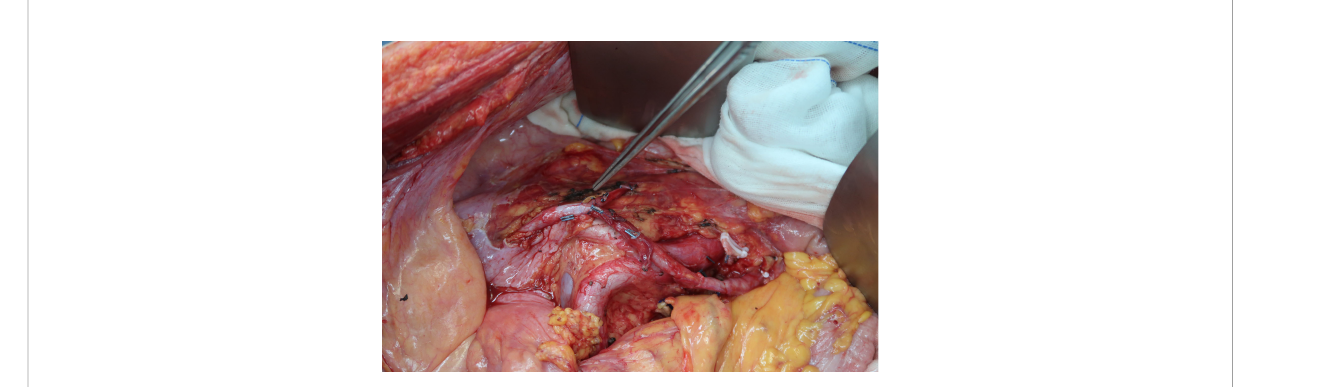
FIGURE 3 Anastomosis of the end of the resected left ureter to the side of the right